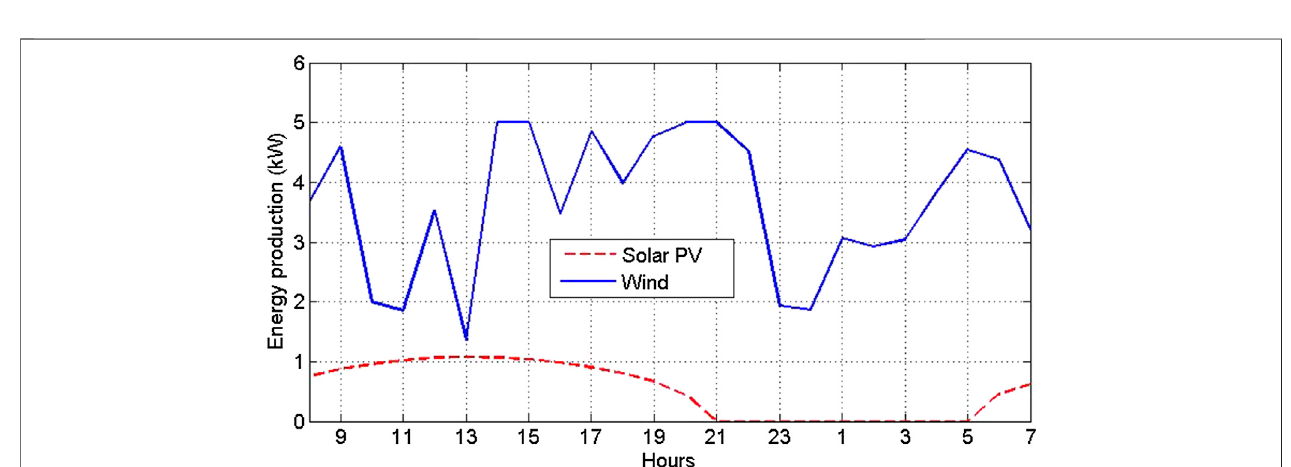
FIGURE 4 | Renewable energy